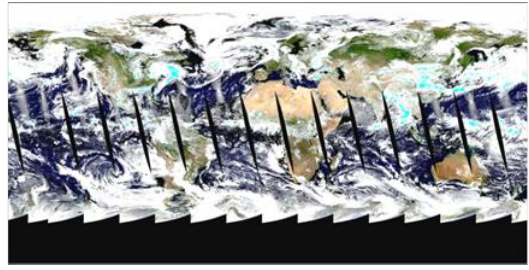
Fig. 2. Aqua product of MDY09CMG (28 June 2015) in true colour